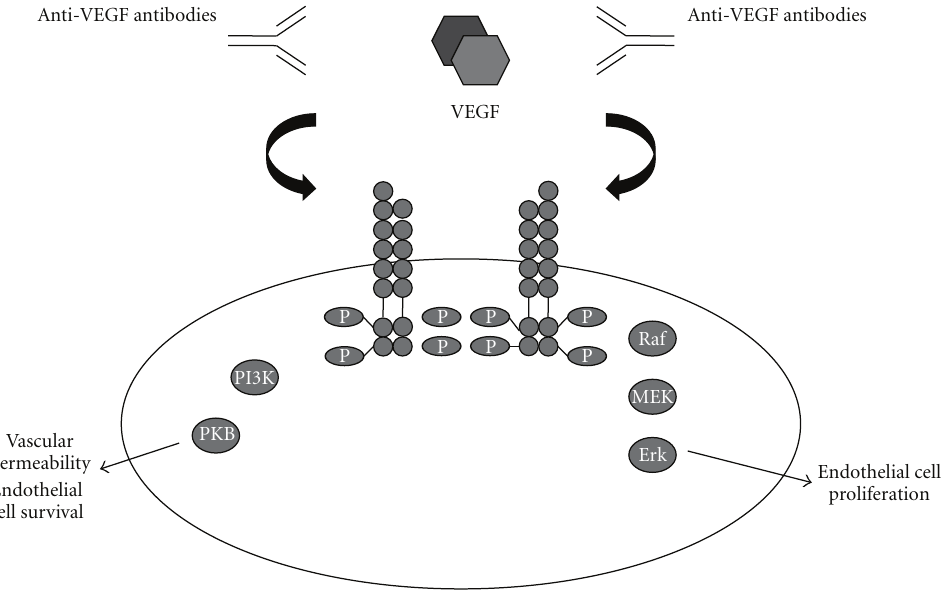
Figure 1: VEGF pathway and VEGF